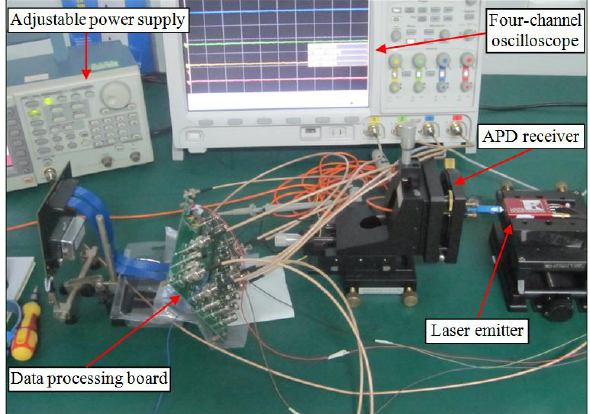
Figure 4. The measurement platform in the laboratory